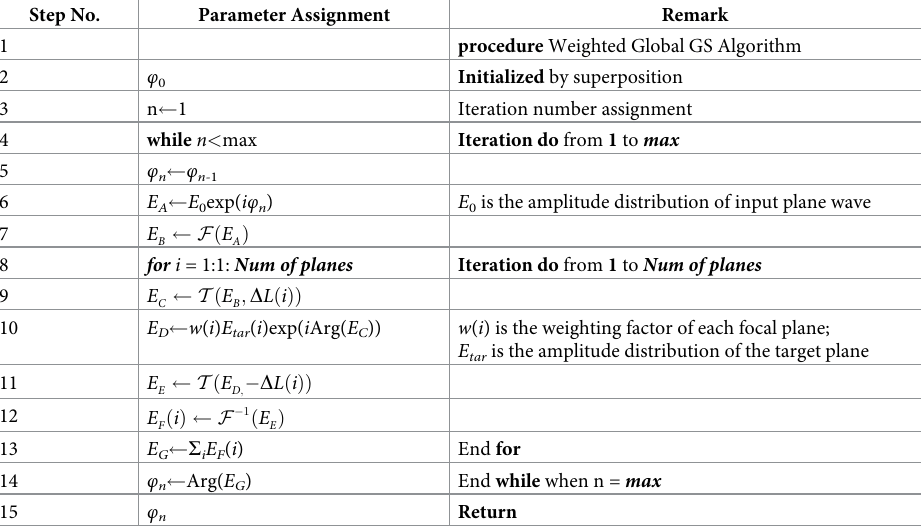
Table 1. Weighted Global Gerchberg-Saxton algorithm for